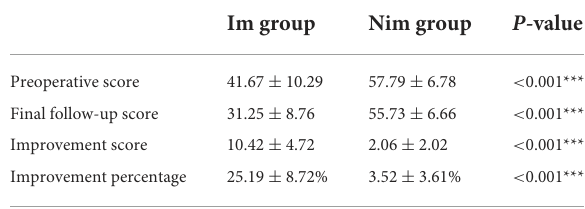
TABLE 1 Baseline characteristics, follow-up time and surgical segments of the two groups of patients.